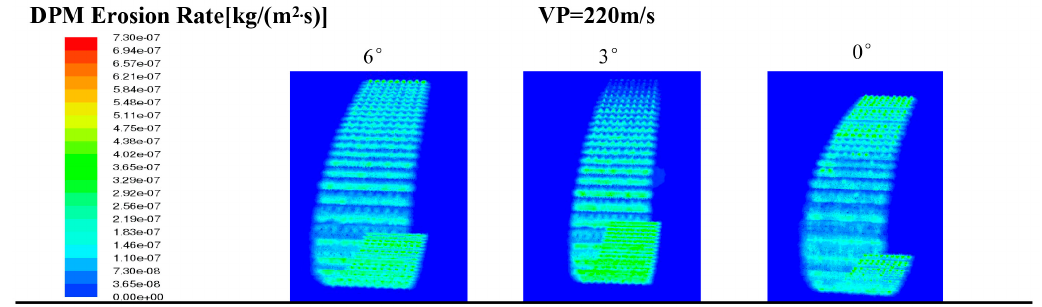
Figure 15. Three-dimensional erosion rates of bionic coating of V-type at impact speed of 220 m/s.